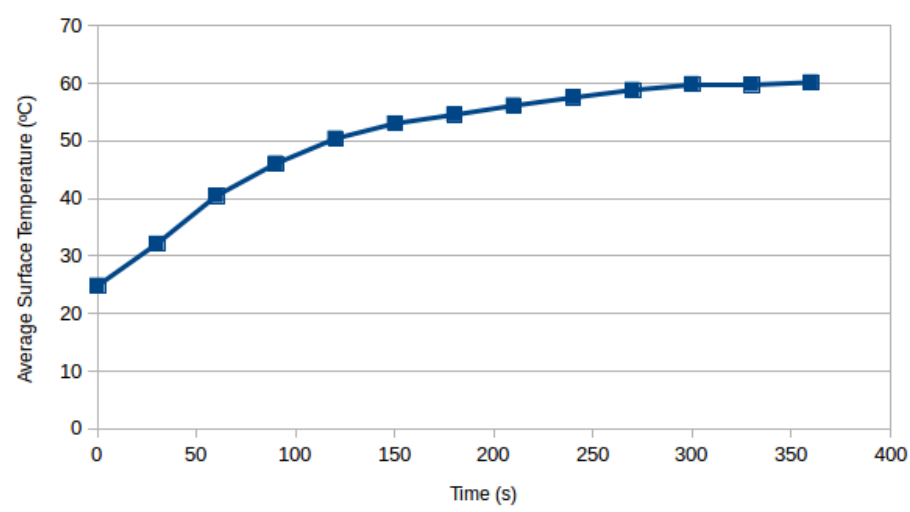
Figure 4. Average surface temperature of slides as a function of time for the open-source slide dryer (30-slide version).